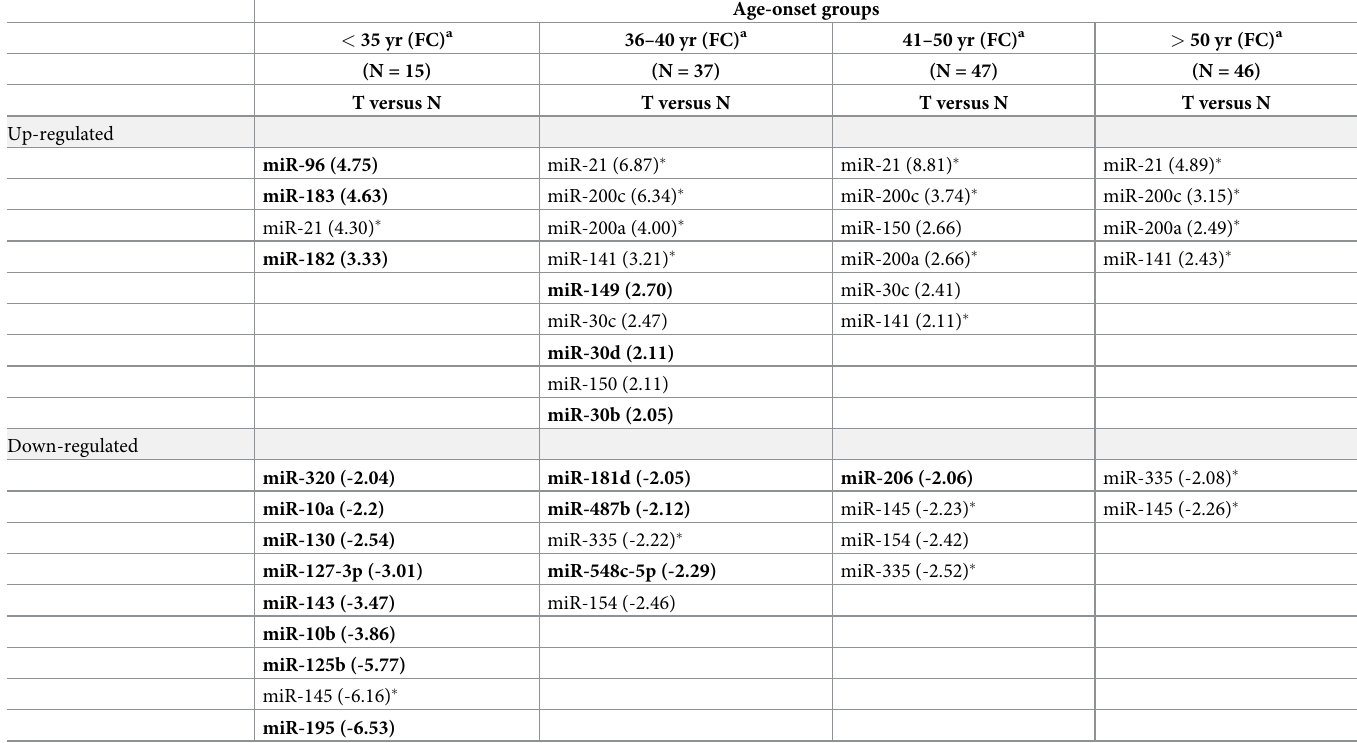
Table 6. Differential expression of miRNAs in specific age-onset